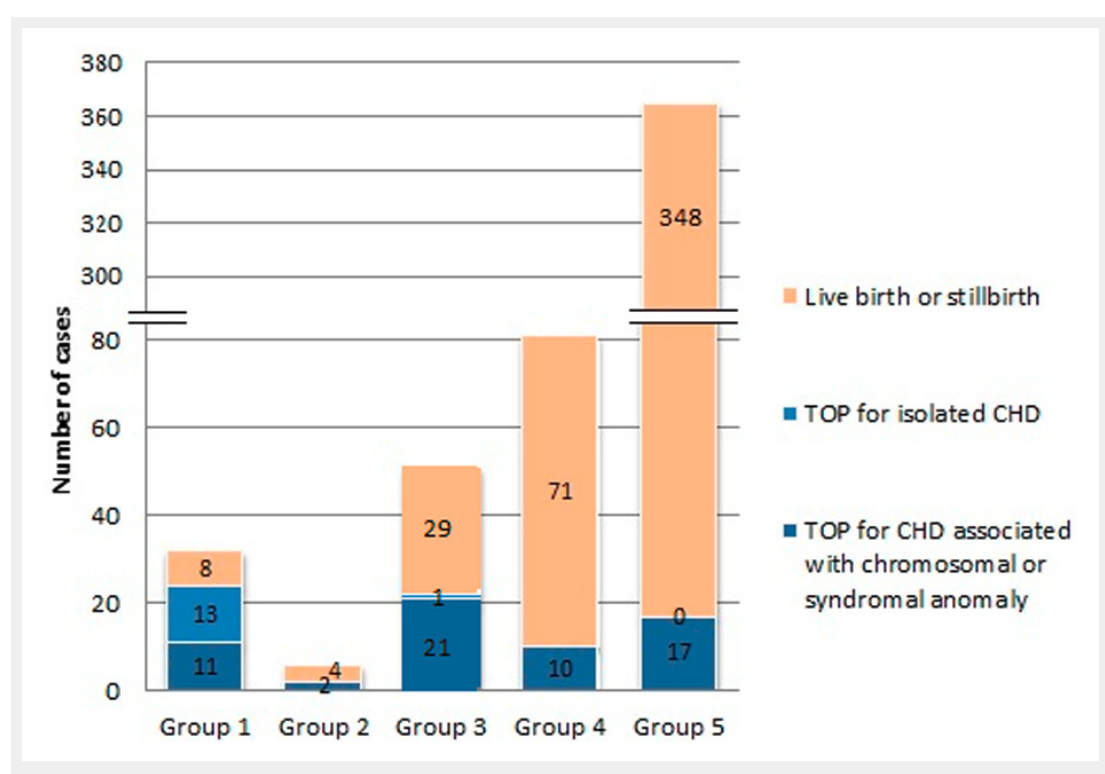
Figure 4 The outcomes of pregnancies in groups 1–5 (live birth or stillbirth, TOP for isolated CHD, or TOP for CHD associated with a chromosomal or syndromal